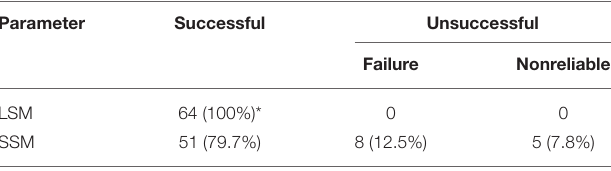
TABLE 2 | Technical success and reliability of LSM and SSM by 2D-SWE in rats with NAFLD. Parameter Successful Unsuccessful Failure